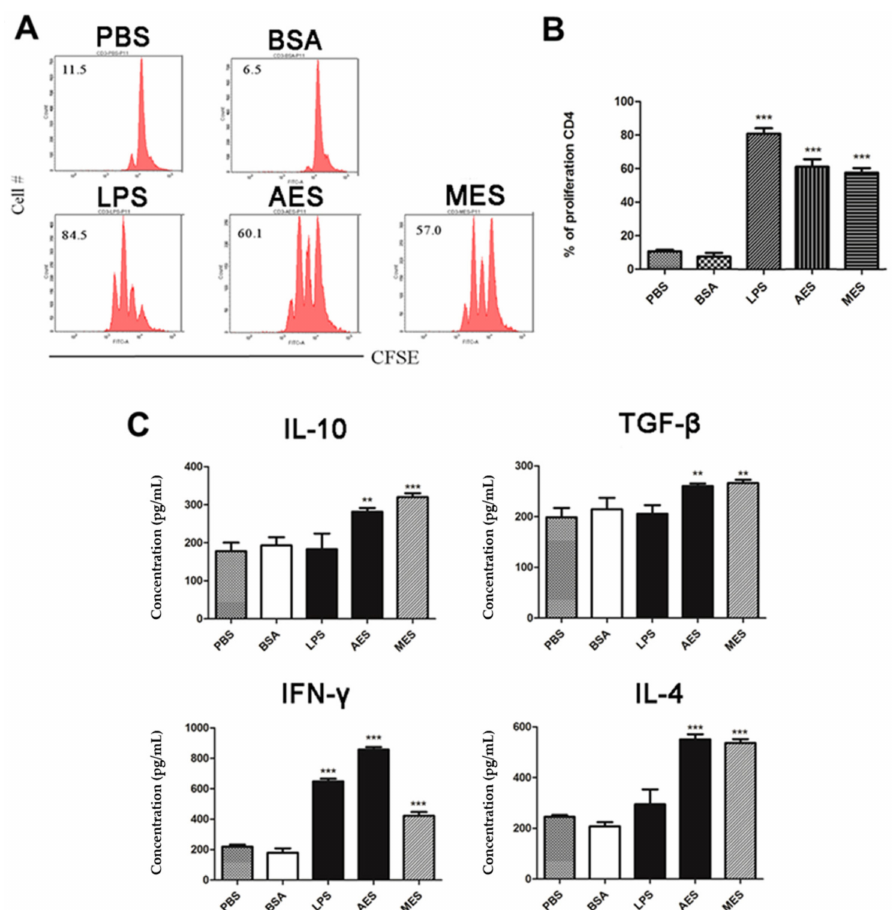
Figure 6. Proliferation and cytokines production of T cells in response to T. spiralis ES ( Ts ES)-treated DCs: CD4 + T cells were isolated from splenocytes of T. spiralis -infected BALB / c mice, labeled with CFSE, and co-cultured for 72 h with BMDCs (stimulated with PBS, BSA, LPS, AES, or MES) in the presence of anti-CD3 / anti-CD28. ( A , B ) FACS of T cells proliferation from one experiment of three independent experiments is presented. ( C ) Cytokine levels were measured in cell culture supernatants using ELISA. Data are expressed as means ± SDs from three independent experiments. Each experiment was done in triplicates. ** p < 0.01; *** p < 0.001, compared to the PBS